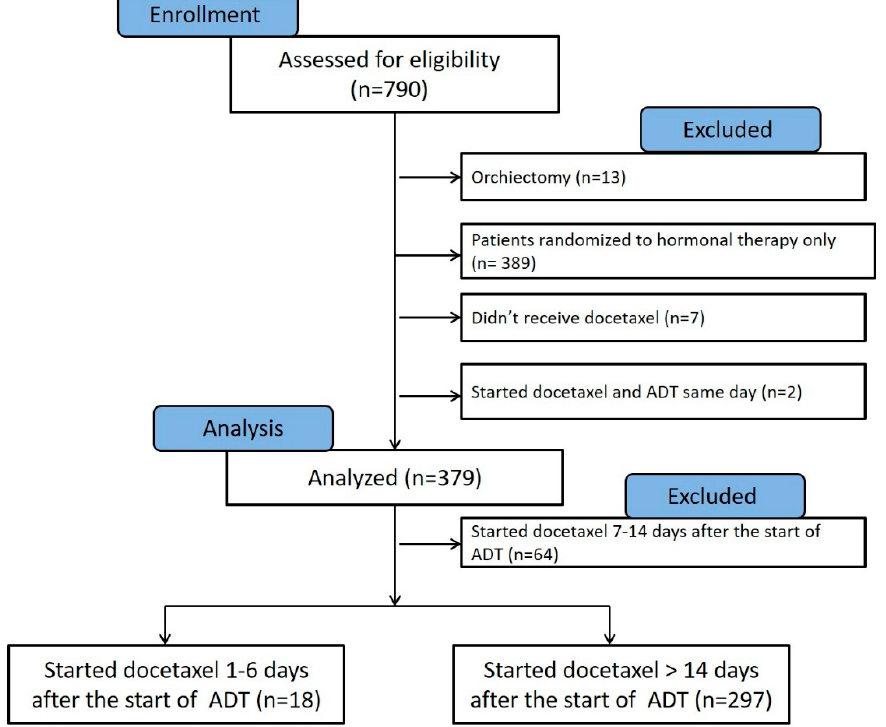
Figure 2. Consort chart showing the patients from the CHAARTED trial that were assessed for eligibility in our analysis ( n = 790). Patients who underwent orchiectomy ( n = 13), treated with hormonal therapy alone ( n = 389), randomized to hormonal therapy and docetaxel but did not receive docetaxel ( n = 7), and those who started ADT on the same day of receiving docetaxel ( n = 2) were excluded from analysis. Patients who started docetaxel 7–14 days from the start of ADT ( n = 64) were excluded from the final Kaplan–Meier, as they likely had varying androgen levels at the time of docetaxel initiation.